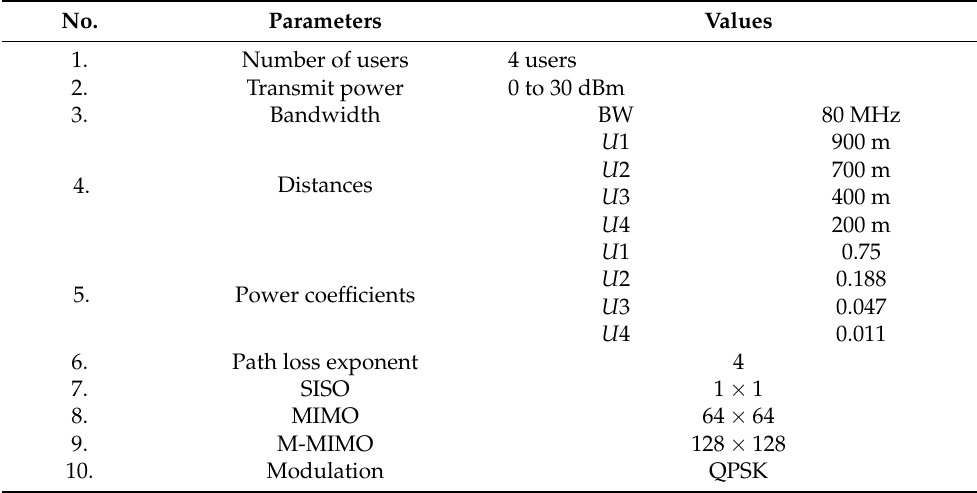
Table 1. Simulator parameters for the DL scenario.